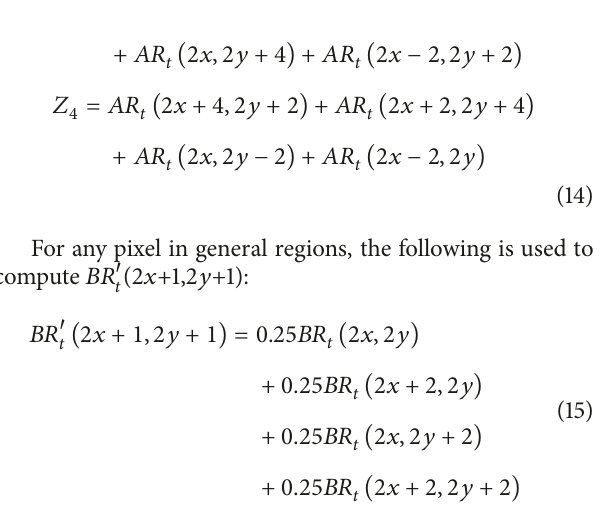
Figure 4: The method of partition